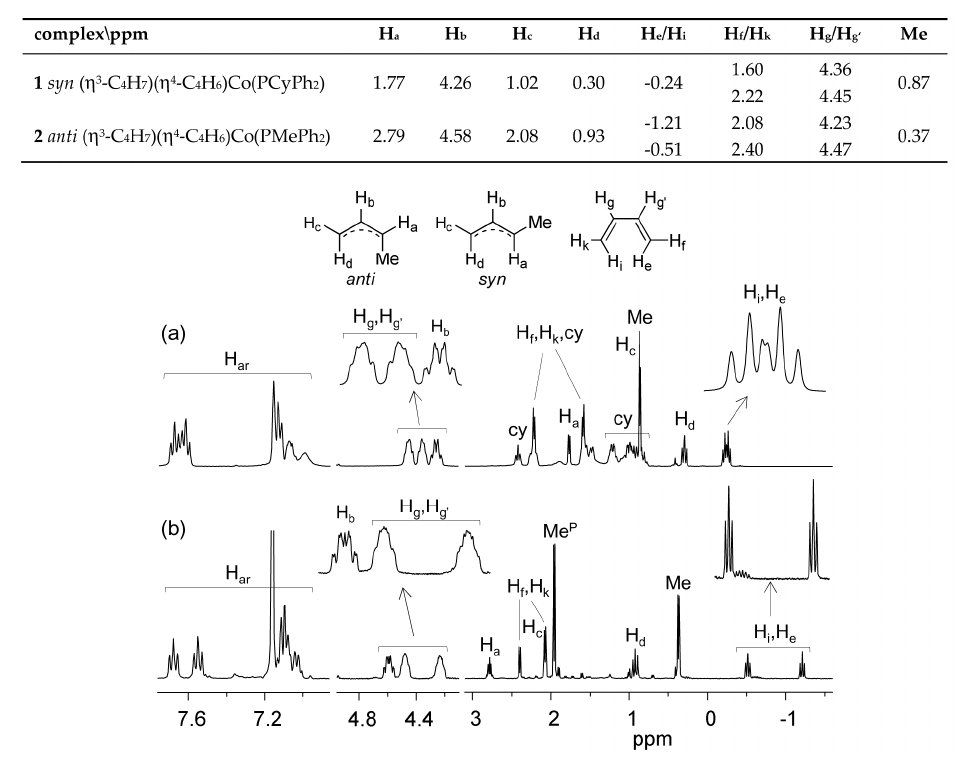
Figure 2. 1 H NMR spectra of ( a ) ( η 3 ‐ C 4 H 7 )( η 4 ‐ C 4 H 6 )Co(PCyPh 2 ) ( 1 ) and ( b ) ( η 3 ‐ C 4 H 7 )( η 4 ‐ C 4 H 6 )Co(PMePh 2 ) ( 2 ) (Me P indicates the protons of the methyl on the ligand phosphorus atom, H ar = aryl protons, cy = cyclohexyl protons).